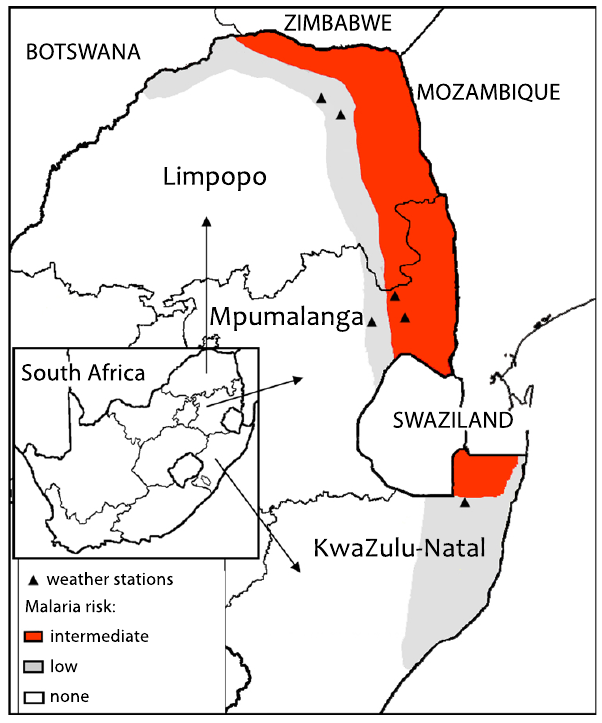
Fig. 1. Map of the investigated provinces in South Africa, col- ored by level of malaria risk. The locations of the weather sta- tions for each province are marked with black triangles (see: http: //www.malaria.org.za/Malaria Risk/Risk Maps/risk